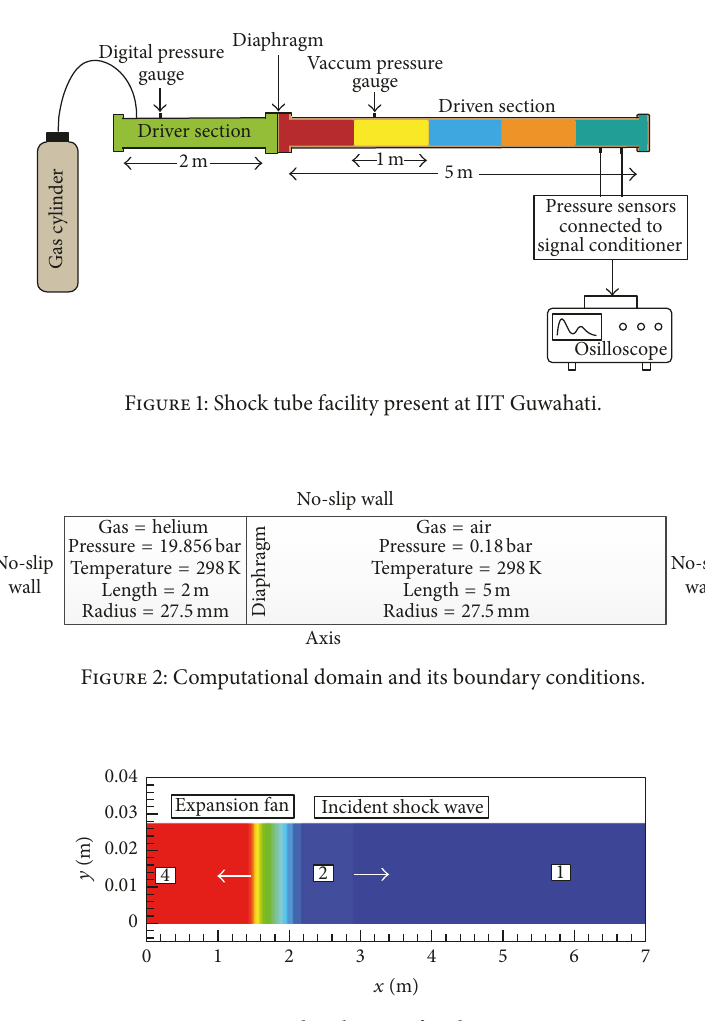
Figure 3: Pressure distribution after diagram